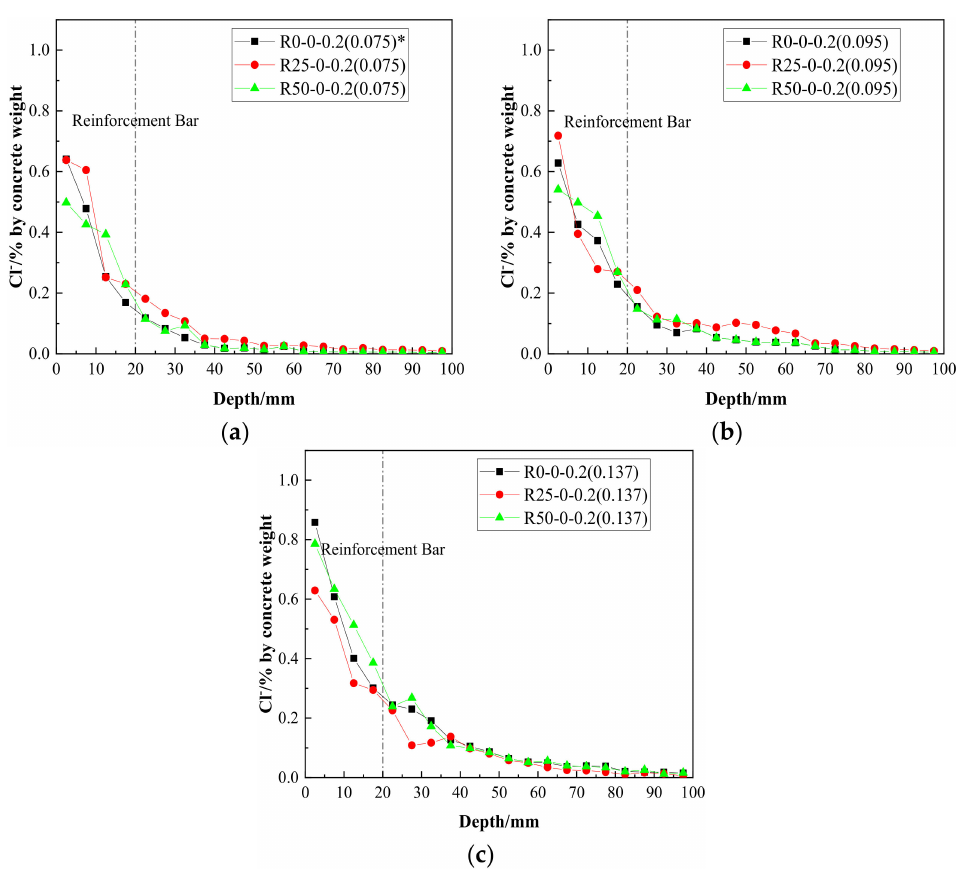
Figure 10. Distribution of chloride ion contents at different depths as a function of aggregate substitution when w = 0.075 mm ( a ), w = 0.095 mm ( b ) and w = 0.137 mm ( c ). Note (*): the values in brackets refer to the actual widths of the cracks selected in the specified